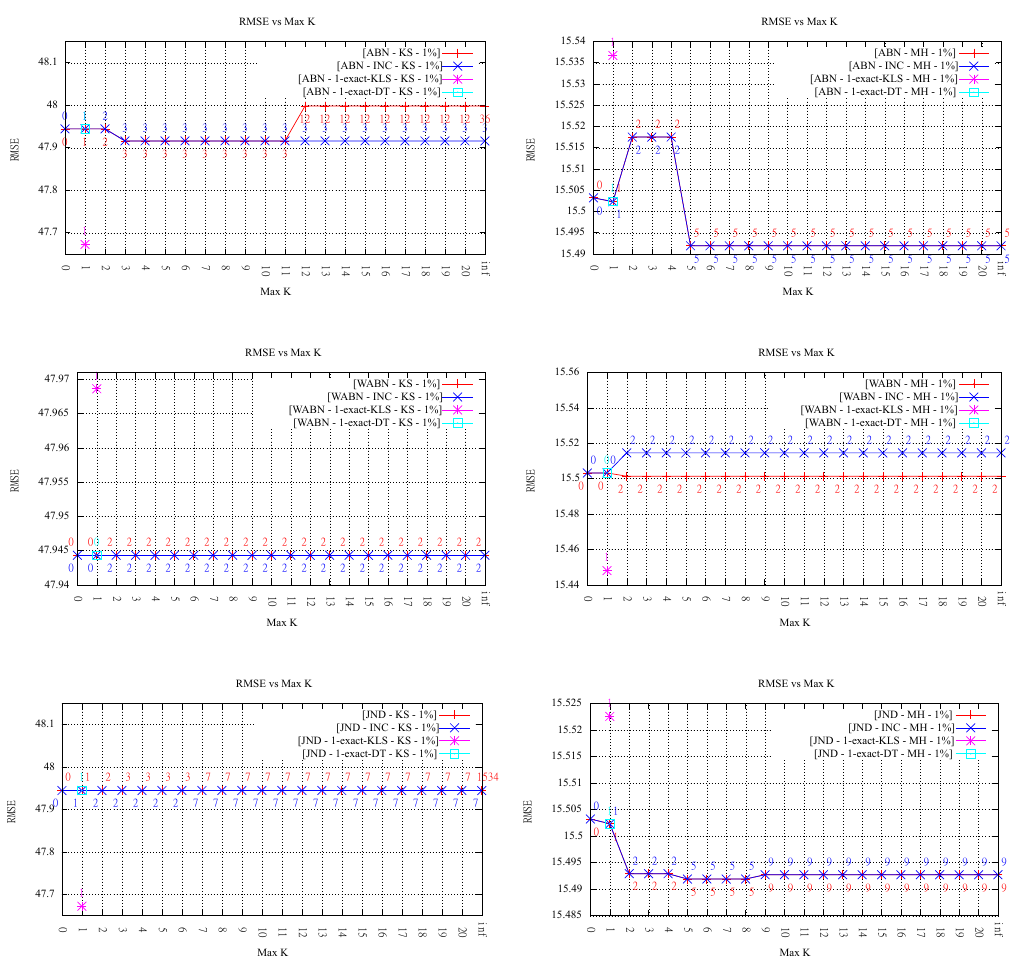
Figure 5. RMSE evaluation for Kinzel Springs ( left ) and Moorehead SE ( right ) over 1% sample point set as the maximum order k increases. In each column, from top to bottom: ABN, WABN and JND. Numbers indicate the final